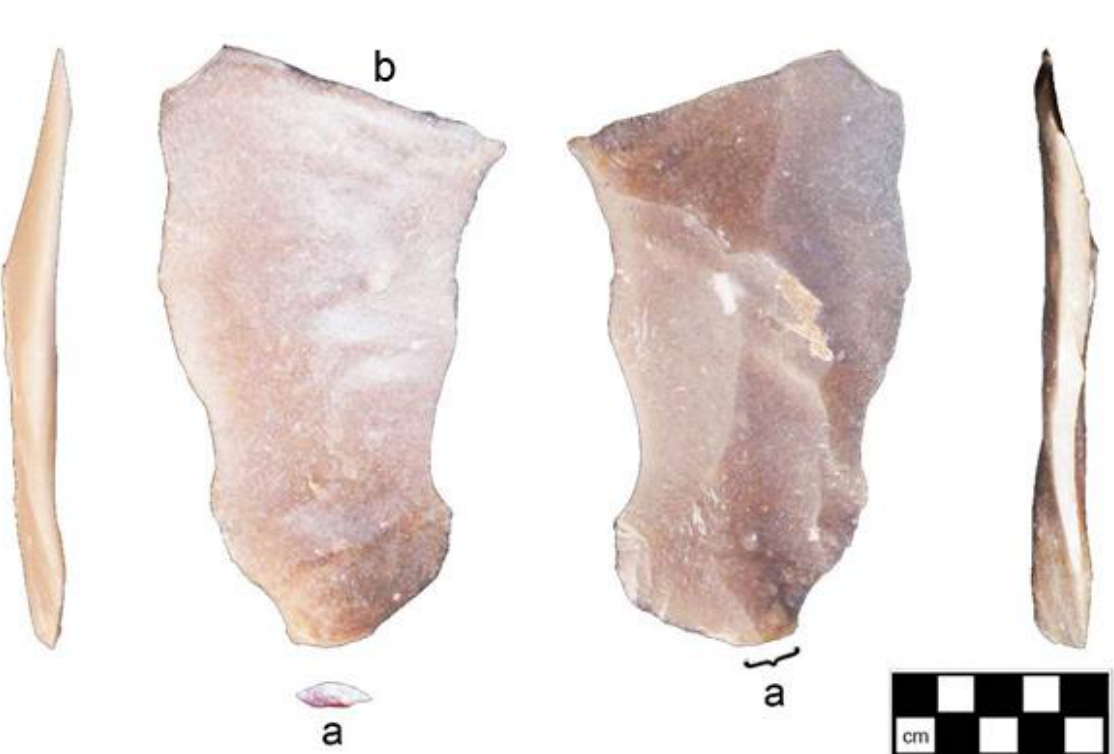
Figure 8. Replica 2 Flake 2 full-face flake. a) platform; b) shallow hinge